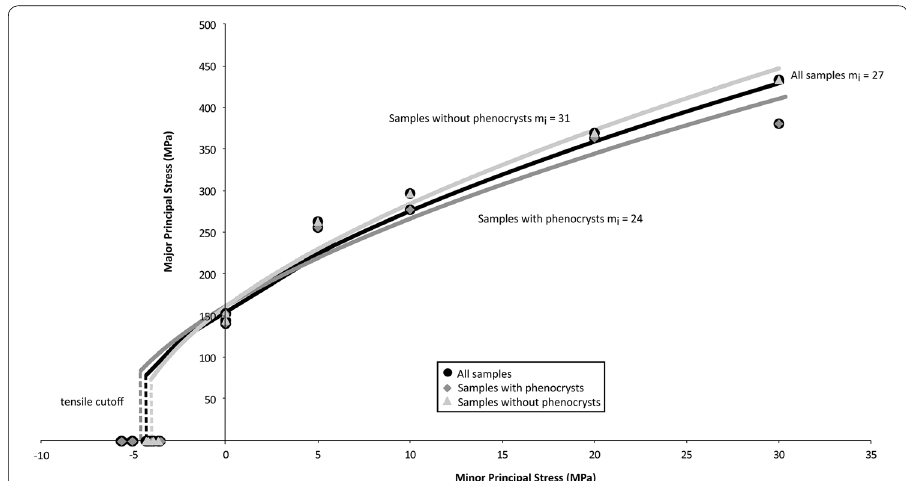
Fig. 7 Triaxial, uniaxial and indirect tensile data and Hoek–Brown failure criterion model fits for the samples from 1558 m depth, showing the fits for samples with and without visible phenocrysts as well as for all samples